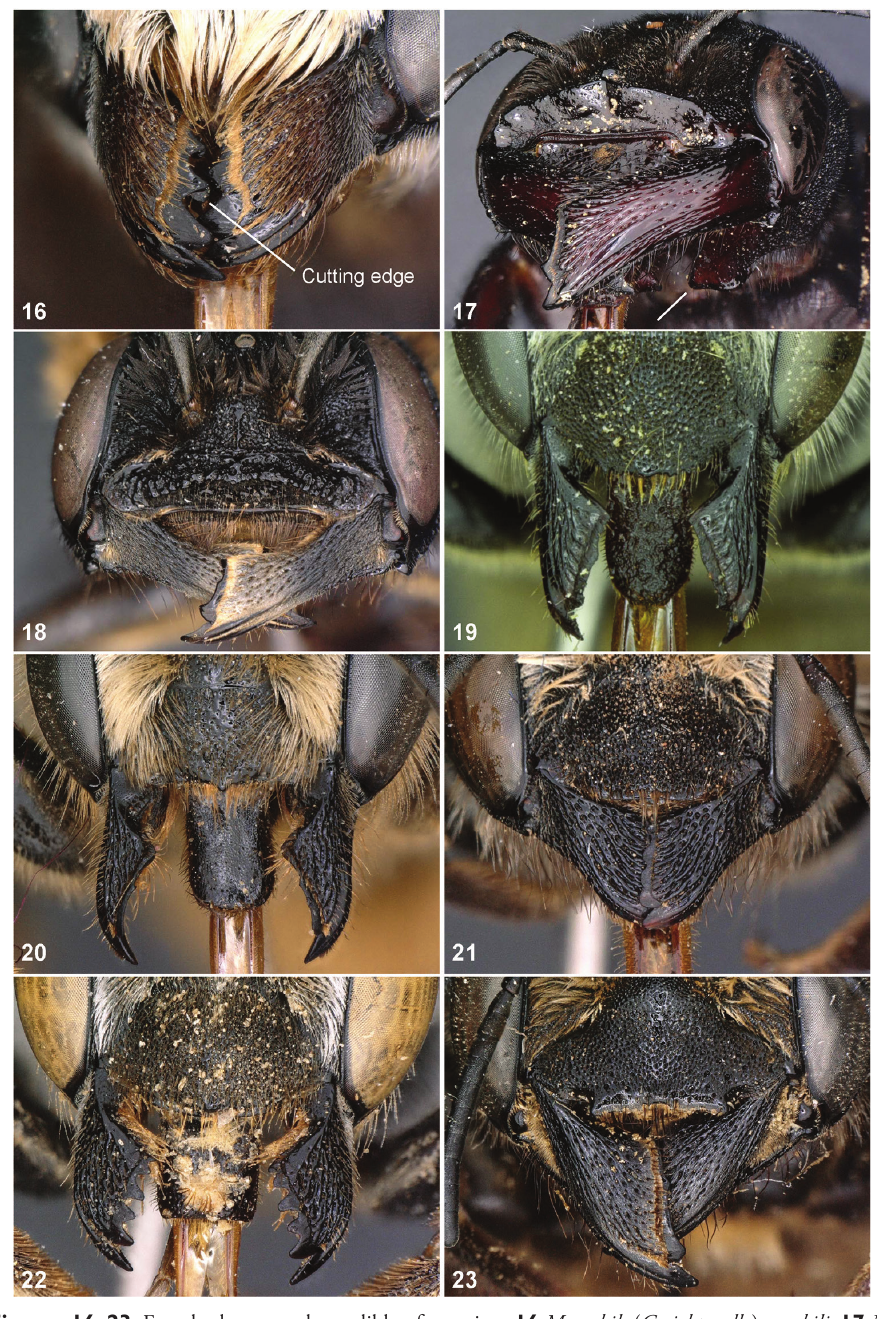
Figures 16–23. Female clypeus and mandibles, front view. 16 Megachile ( Creightonella ) amabilis 17 M. ( Maximegachile ) maxillosa ; the white line indicates the hypostomal tooth 18 M. ( Callomegachile ) sculptur- alis 19 M. ( Chalicodoma ) hungarica 20 M. ( Pseudomegachile ) ericetorum 21 M. ( Pseudomegachile ) incana 22 M. ( Pseudomegachile ) sp . aff incana 23 M. ( Pseudomegachile ) foersteri